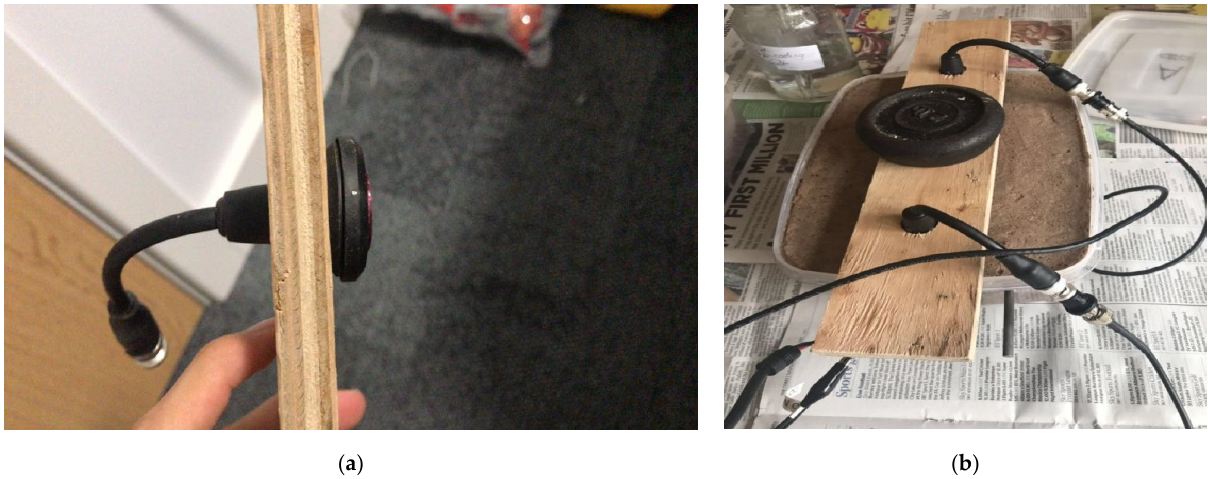
Figure 7. ( a ) Side view showing probe in place in probe holder. ( b ) Probe holder in use during SSS